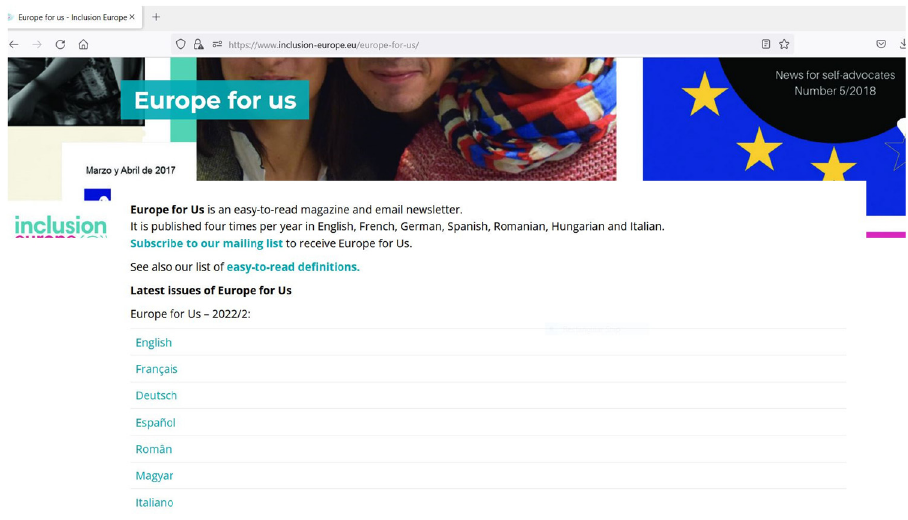
Figure 1: Availability of Europe for us in several